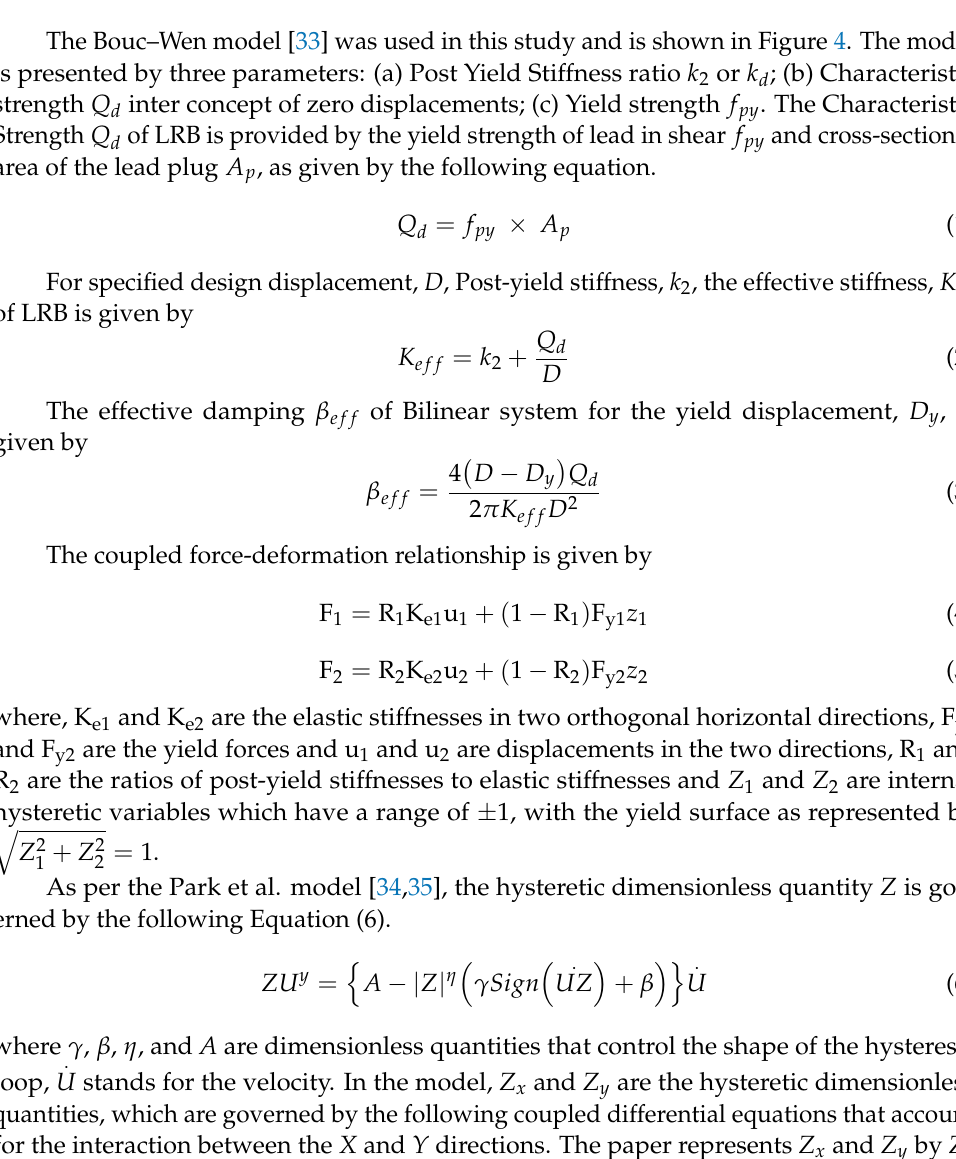
Table 1. Details of the number of elements considered in bridge modeling. Span/Height Nos. of Segments Length of Each Element Location (m) (Elements) Considered (m) 20 20 1 Superstructure 25 25 1 Pier 11 11